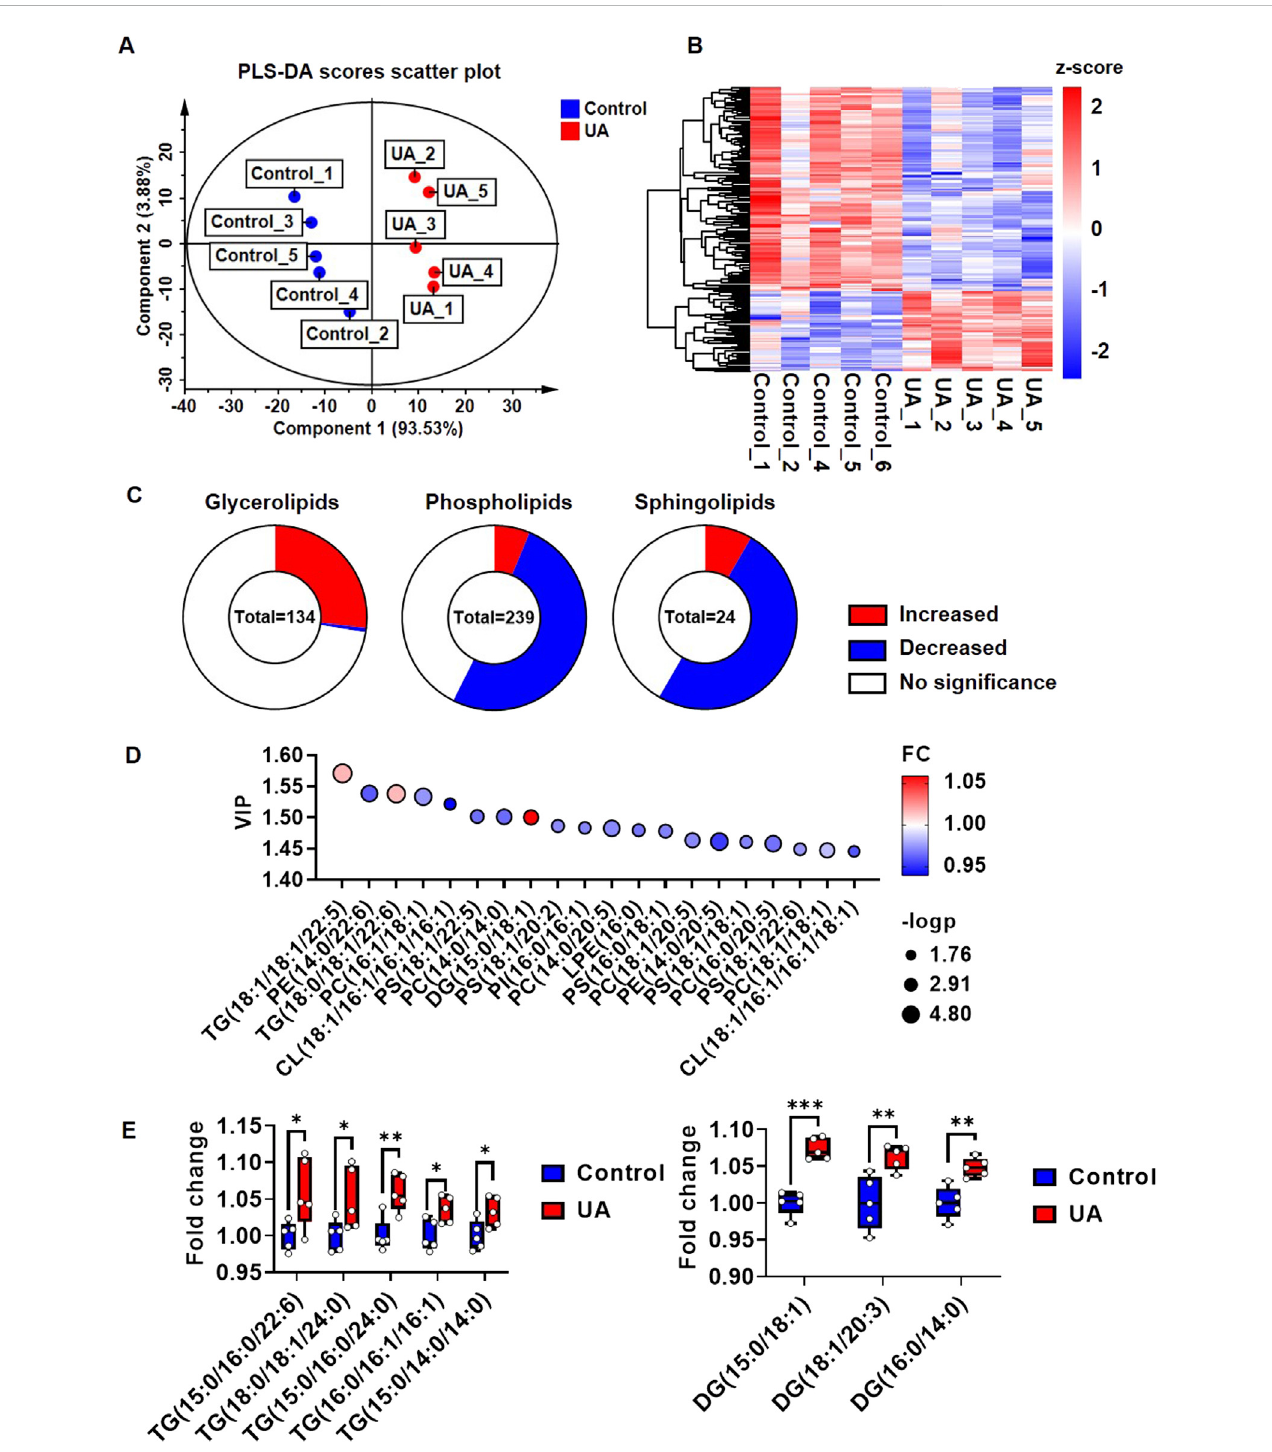
FIGURE 3 Lipidomic pro fi le change of cardiomyocytes under UA stimulation. (A) PLS-DA score scatter plot showing the separation of control group and UA group. Cardiomyocyteswere treated with 15 mg/dL UA. The cells were harvested for lipidomic analysis after 24 h treatment; (B) Heatmap showing the global view of the signi fi cant metabolites of control and UA treated cardiomyocytes; (C) Pie chart showing the changes in lipid composition under UA treated cardiomyocytescomparewithcontrol.P < 0.05wasconsideredassigni fi cance; (D) Bubbleplotsshowingthetop20signi fi cantmetabolitesbasedonVIP values; (E) Box plots showing the top fi ve upregulated TGs and DGs. The results were normalized to the mean value of control ( n =